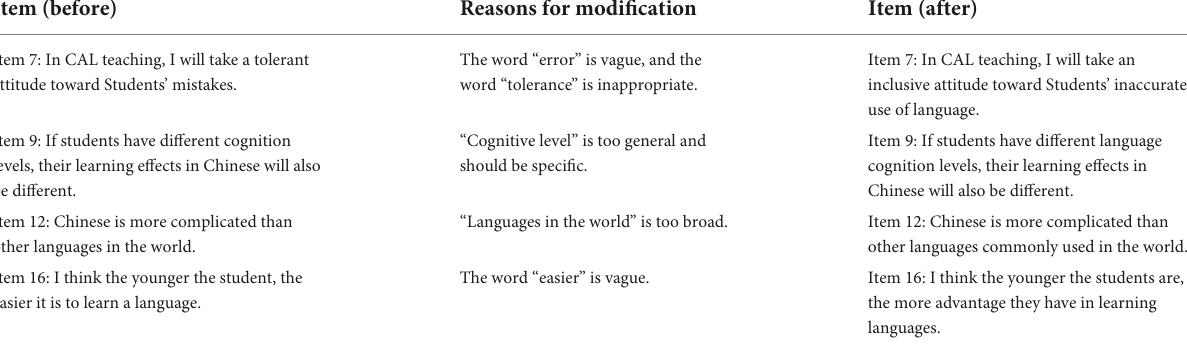
TABLE 2 Modifications of the items after the pilot